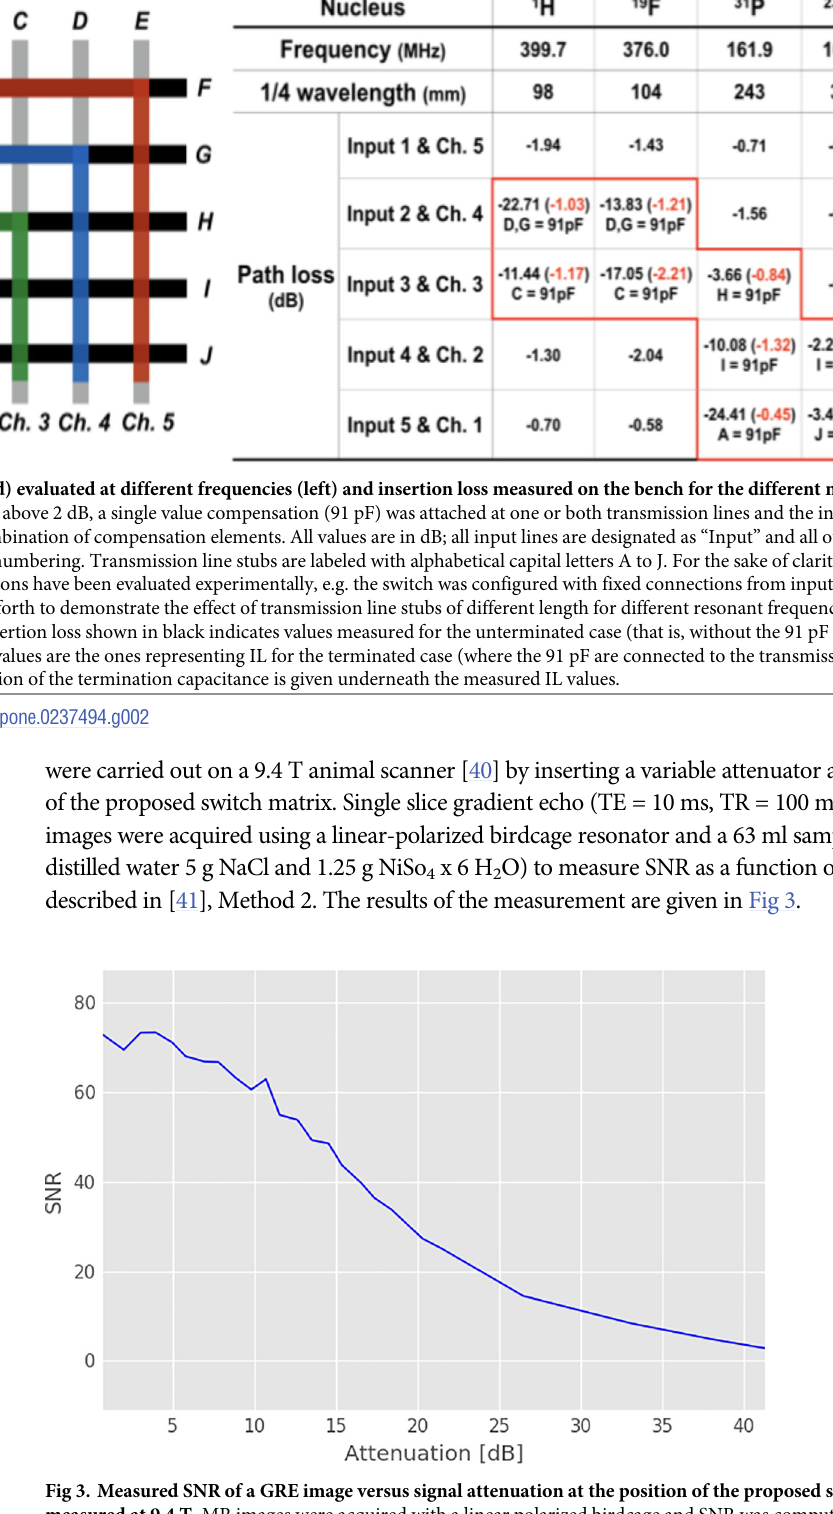
Fig 3. Measured SNR of a GRE image versus signal attenuation at the position of the proposed switch matrix measured at 9.4 T. MR images were acquired with a linear polarized birdcage and SNR was computed according to Method 2 described in